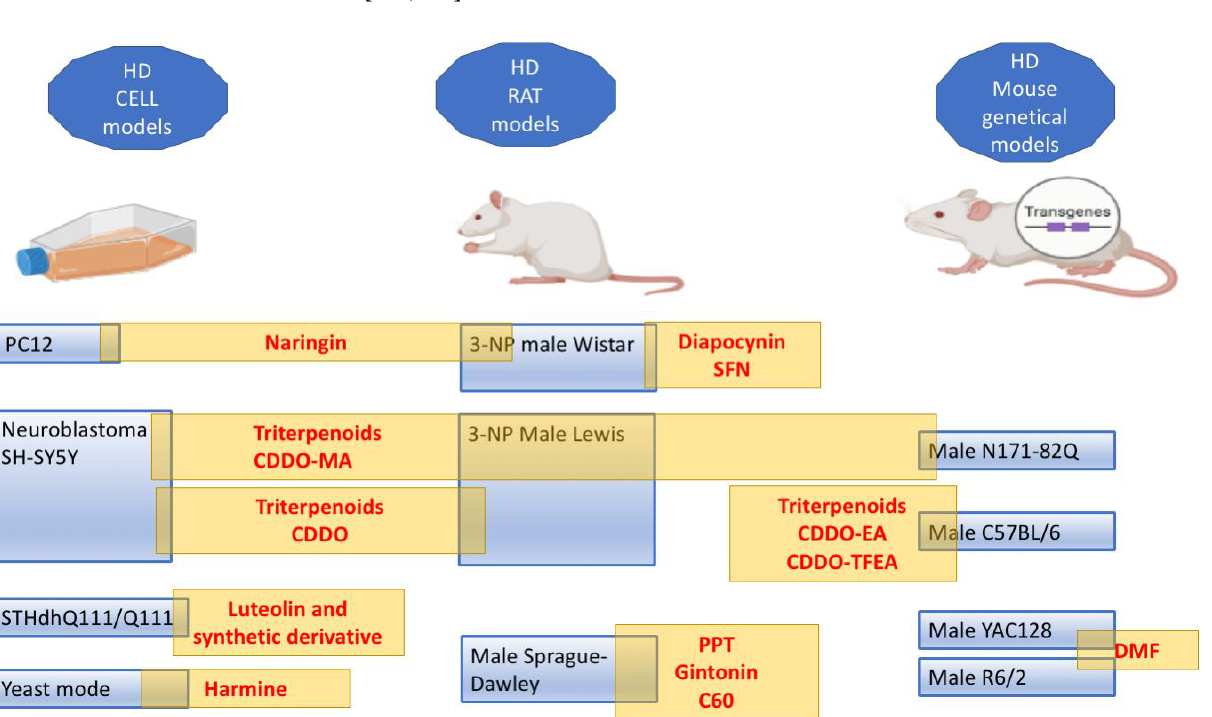
Figure 3. Evidence from substances treatment supporting a role for Nrf2 in HD. This figure reports a summary of results from substances tested in vitro and/or in vivo. The yellow rectangles reported substances active on the Nrf2 pathway in the different models (created in BioRender.com).